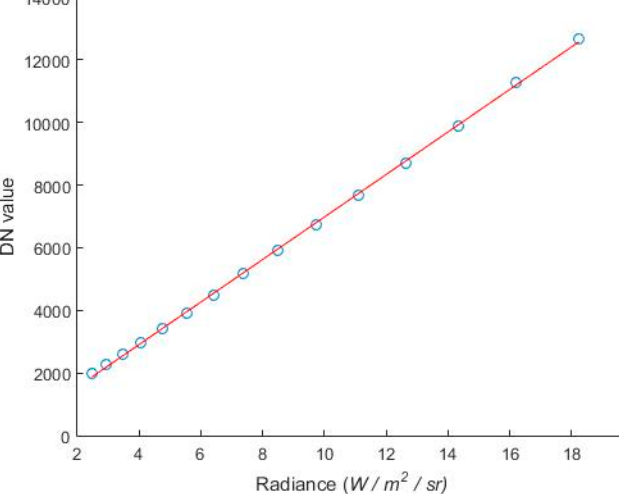
Figure 5. Fitted straight line with the least square method.